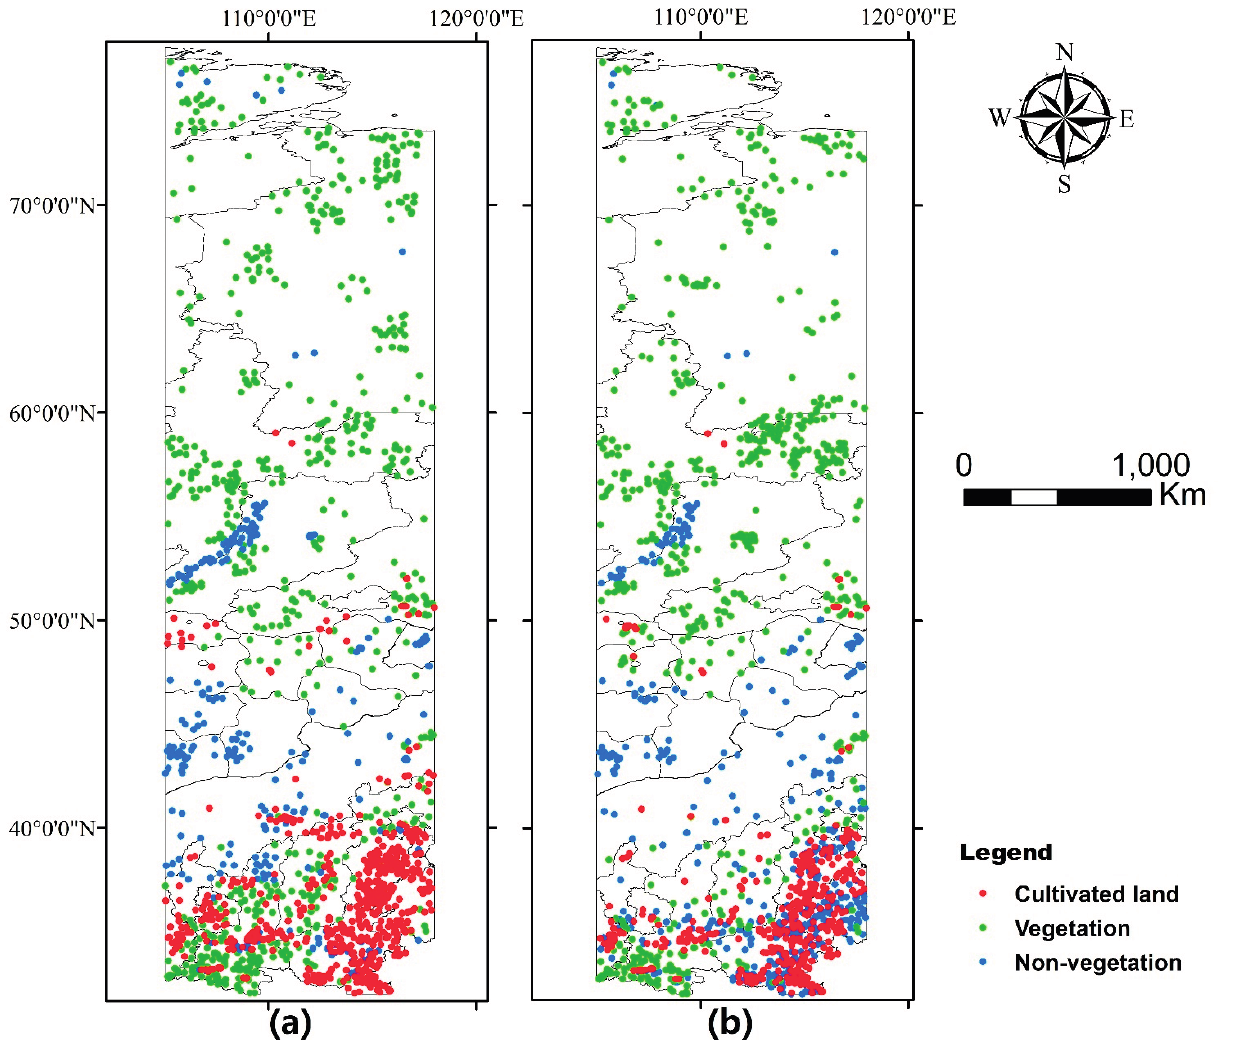
Figure 5. Sample distribution in the NSTNEA in 2000 and